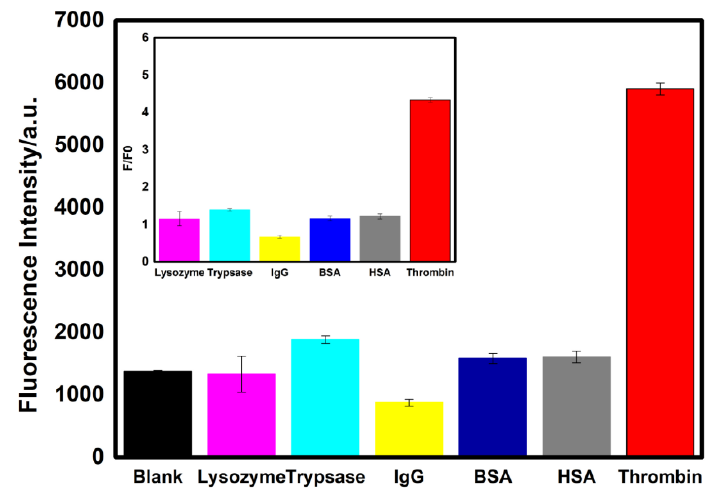
Figure 4. Selectivity evaluation of the biosensor for the detection of thrombin against other proteins of Lysozyme, Trypsase, lgG, BSA, and HSA. The concentration of the thrombin was 0.2 µM. However, the concentration of Lysozyme,Trypsase, lgG, BSA, and HSA was 2 µM. No thrombin or other proteins were used in the blank group. Inset: the changes in fluorescence intensity (F/F 0 ), F and F 0 , are the fluorescence intensities in the presence and absence of protein, respectively. The error bar was calculated in three independent experiments.